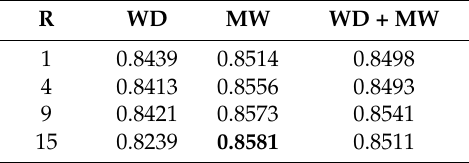
Table A14. Average accuracy of WeiNet for each method at different augmentation ratios, R , for the Ninapro-DB1 dataset. The value in bold corresponds to the highest